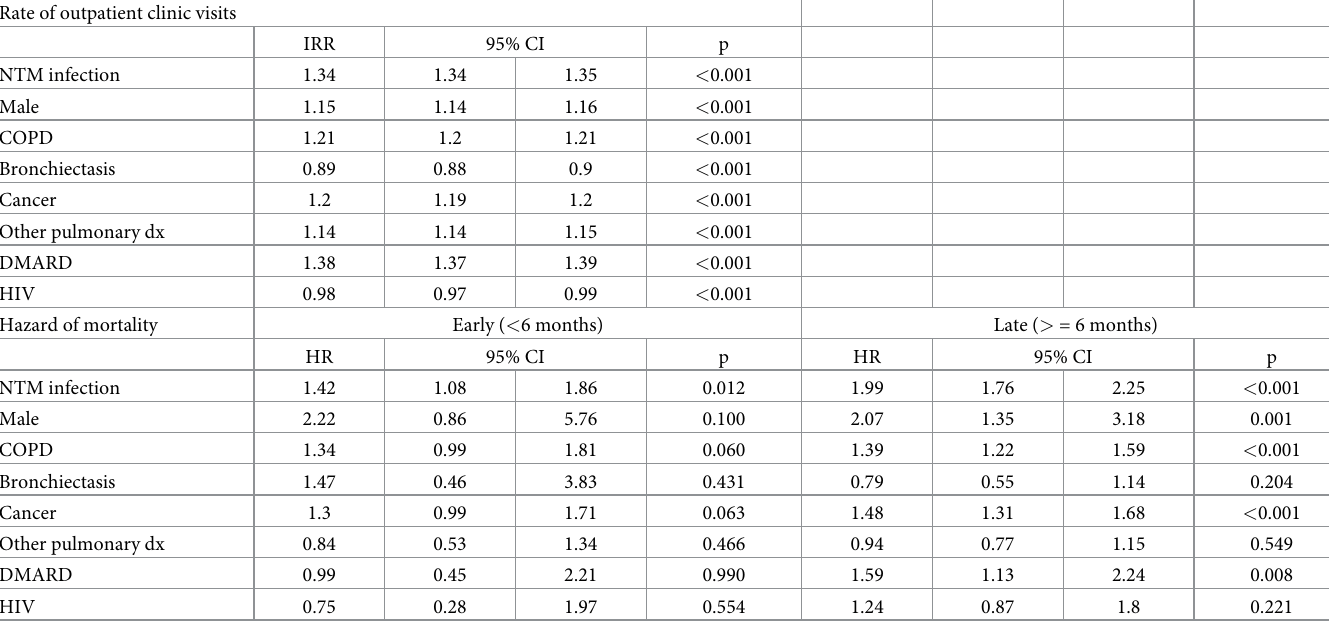
Table 3. Multivariable models of outpatient clinic visit rates and mortality. Mortality is split into early and late periods in piecewise models.